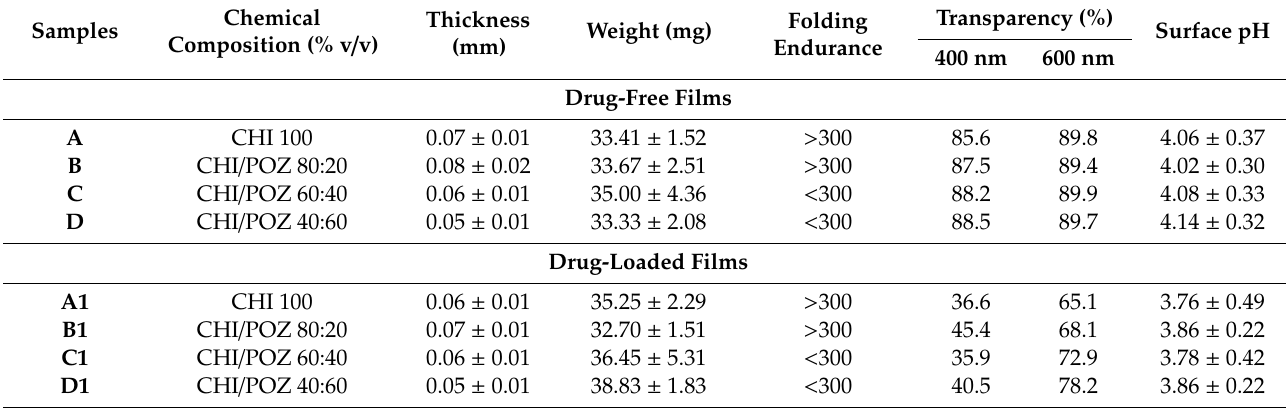
Table 1. Physicochemical parameters of chitosan (CHI) and chitosan / poly(2-ethyl-2-oxazoline) (CHI / POZ) blend films.